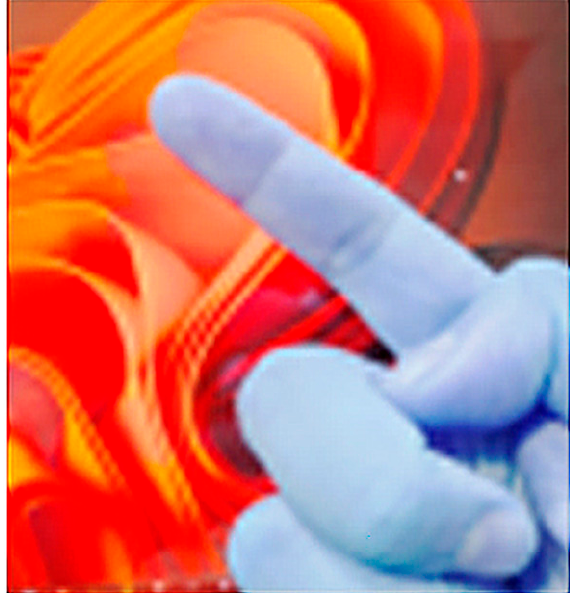
Figure 4. Realize gesture and background segmentation